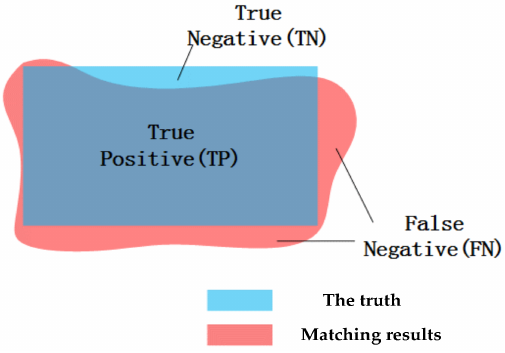
Figure 16. Diagram of object